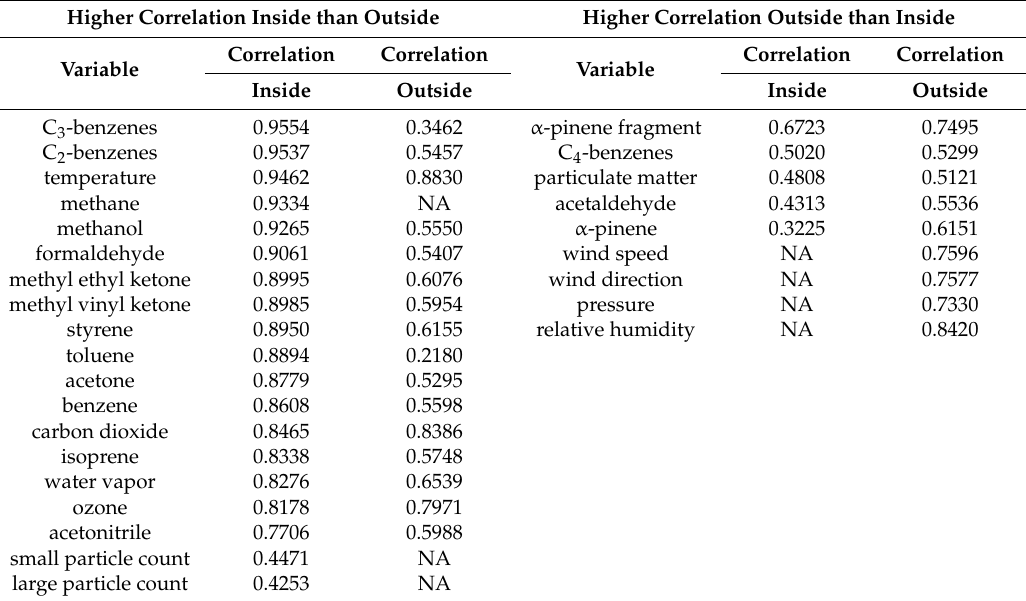
Table 5. Each IAQ variable predicted by random forest (RF) in the aggregated dataset IAQ 1_2